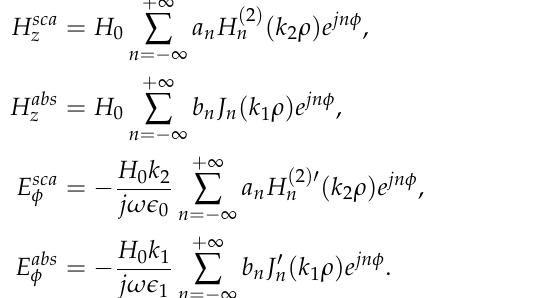
Figure 5. For the excitation of TM mode, a current generator I TM n at the boundary of cylindrical nanowire, get distributed as internal ( I TM properties ( k 1 / k 2 ) of the nanowire, as shown in Figure 4a,b. Whereas Z TM internal impedance of the nanocylinder with property k 1 / k 2 and Z TM the